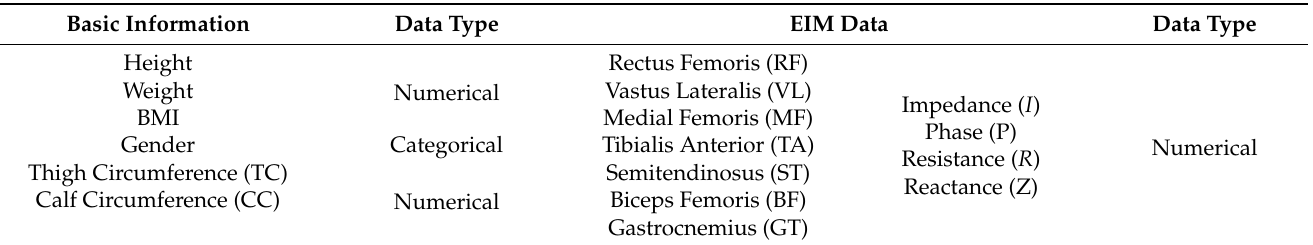
Table 3. Raw parameters including EIM parameters of seven muscles and body information of